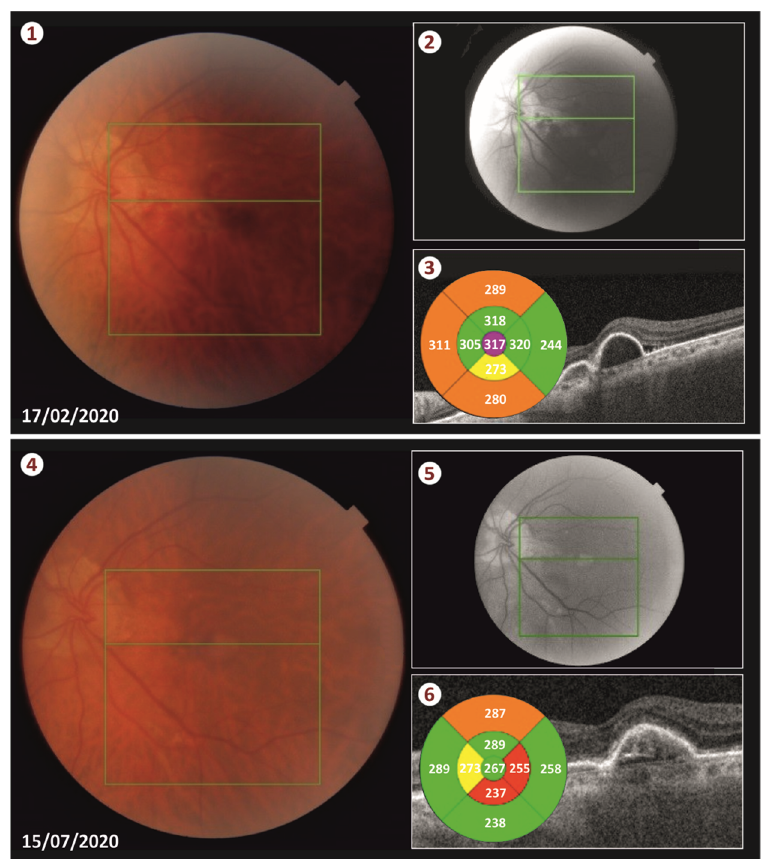
Figure 3. Photos 1 to 3 show the results of the treatment with the proposed procedure twelve days after the surgery, showing an impressive reduction in the CMT, while photos 4 to 6 show the long-term result of the treatment with the proposed procedure about five months after the surgery, indicating a normalization of the patient’s CMT.